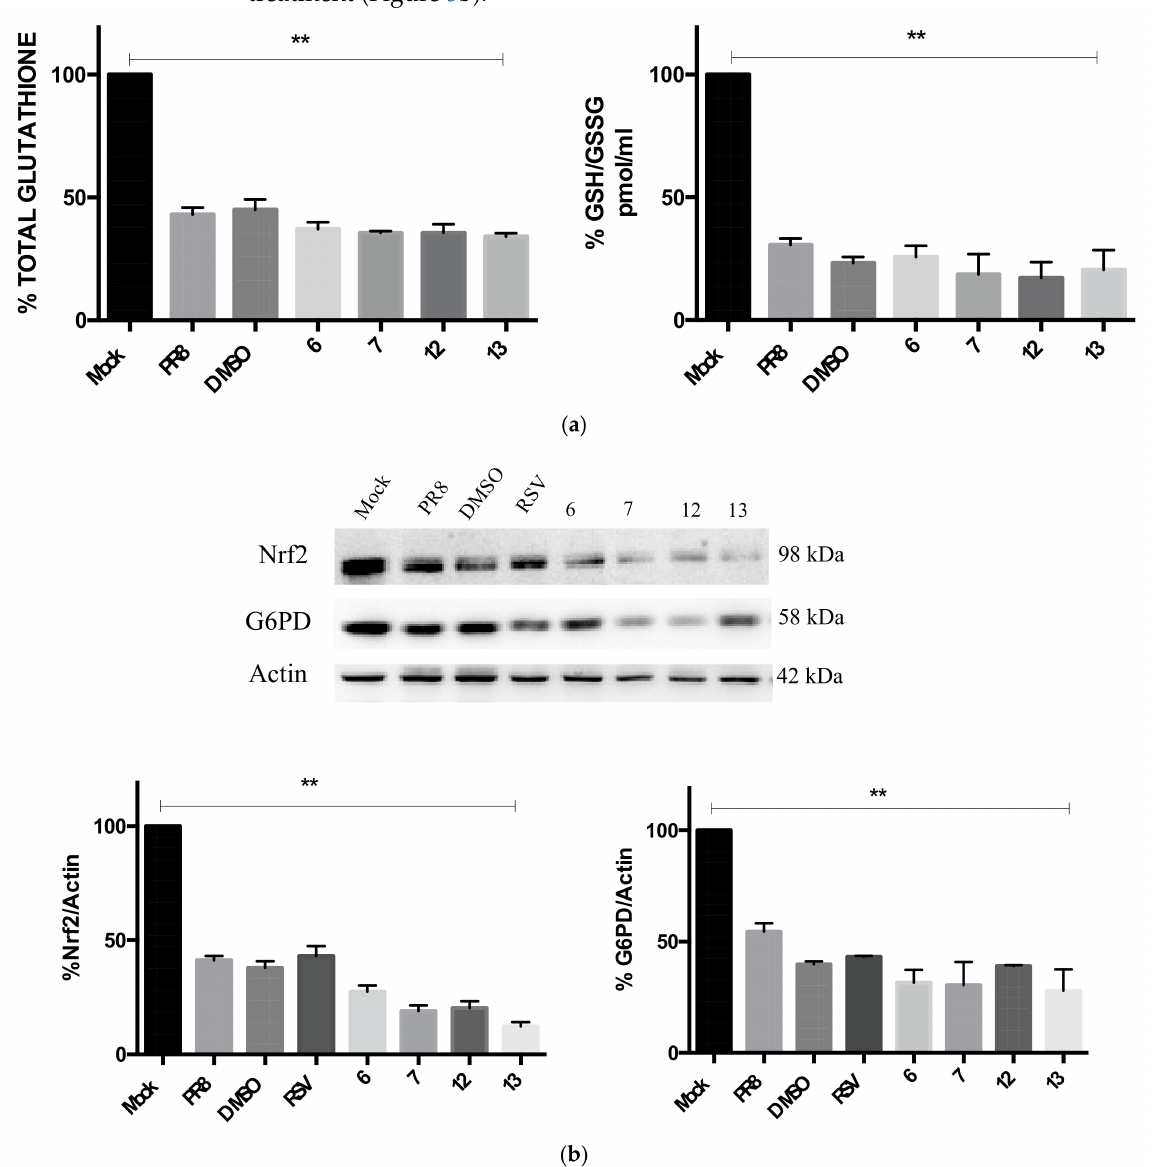
Figure 5. Compounds 6 , 7 , 12 , and 13 do not rescue the GSH-mediated antioxidant response. ( a ) Total glutathione (left graph) and GSH/GSSG ratio (right graph) measured in A549 cells after 24 h of influenza A/PR/8/H1N1 virus infection and treatment with RSV derivatives. The analysis was performed by using a colorimetric assay as described in the methods, and the results are represented as percentages (%) with respect to mock cells. Data are expressed as the means ± S.D. of three experiments, each performed in duplicate ( n = 6) (** p < 0.001 vs. mock). ( b ) Western blot analysis of Nrf2 and G6PD protein expression in A549 cells infected with influenza A/PR/8/H1N1 virus and treated for 24 h. Actin was used as loading control. The panel below represents the densitometry analysis of both proteins normalized to actin. Data are expressed as means ± S.D. of three experiments performed (** p < 0.001 vs.